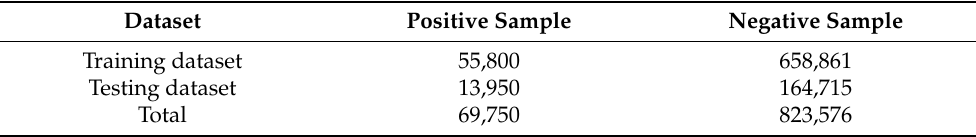
Table 4. The information of the experimental